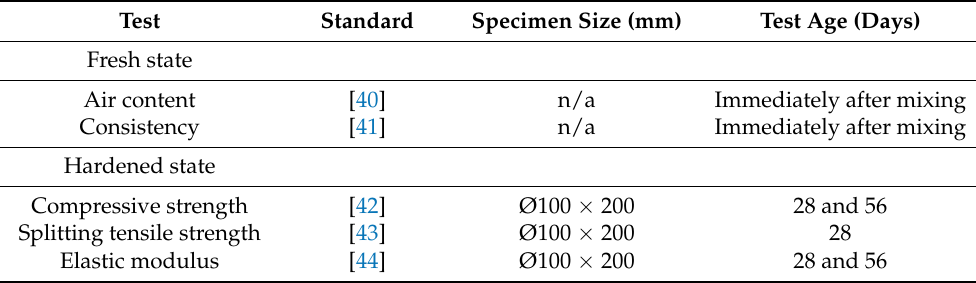
Table 4. Summary of testing